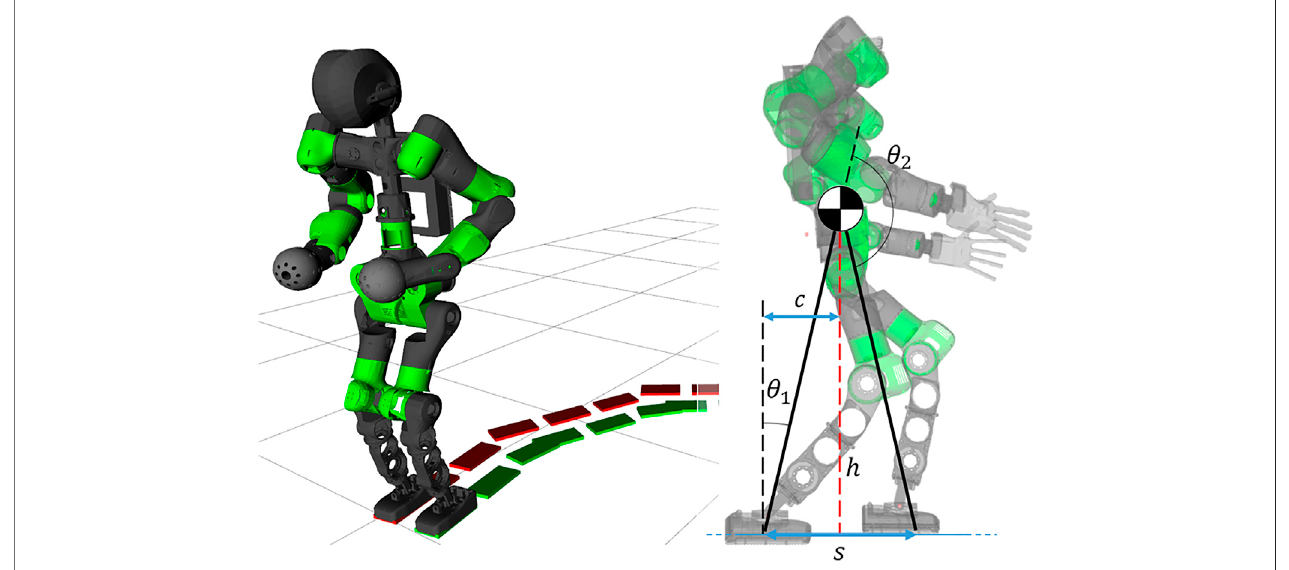
FIGURE1| Left:thehumanoidrobotCOMAN+walkingwhilechangingdirection.Right:thetemplatemodelfortheVC,thecompasswalker,superimposedonthe robot